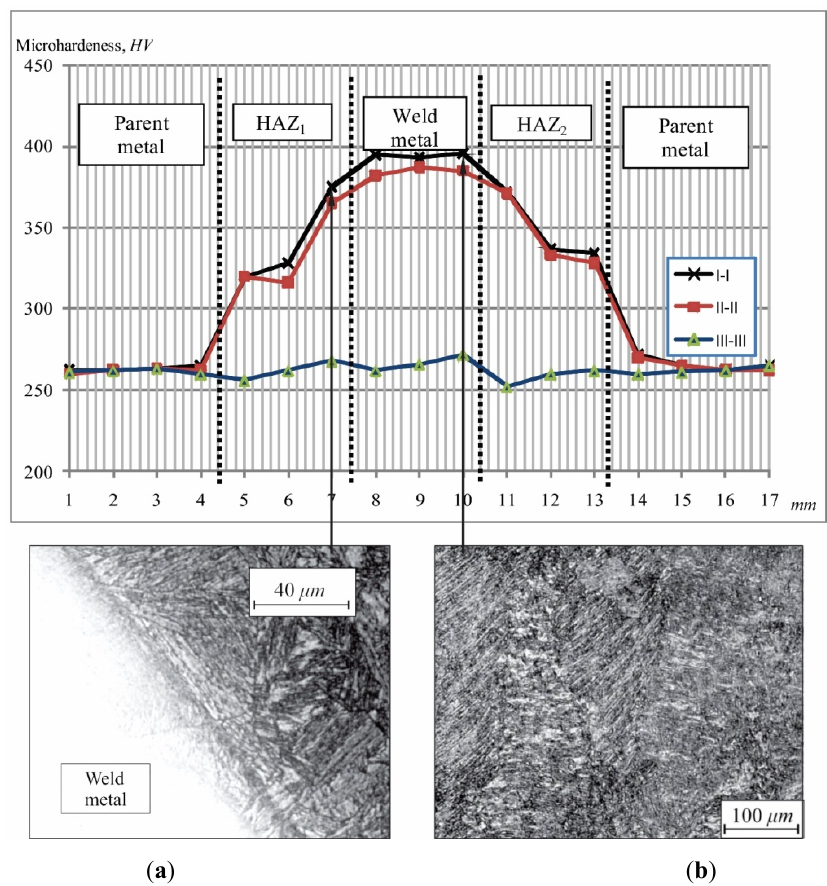
Figure 5. Microhardness distribution and microstructure of the MMA / MAG samples: ( a ) zone of transition between the weld metal and HAZ; ( b ) weld metal.